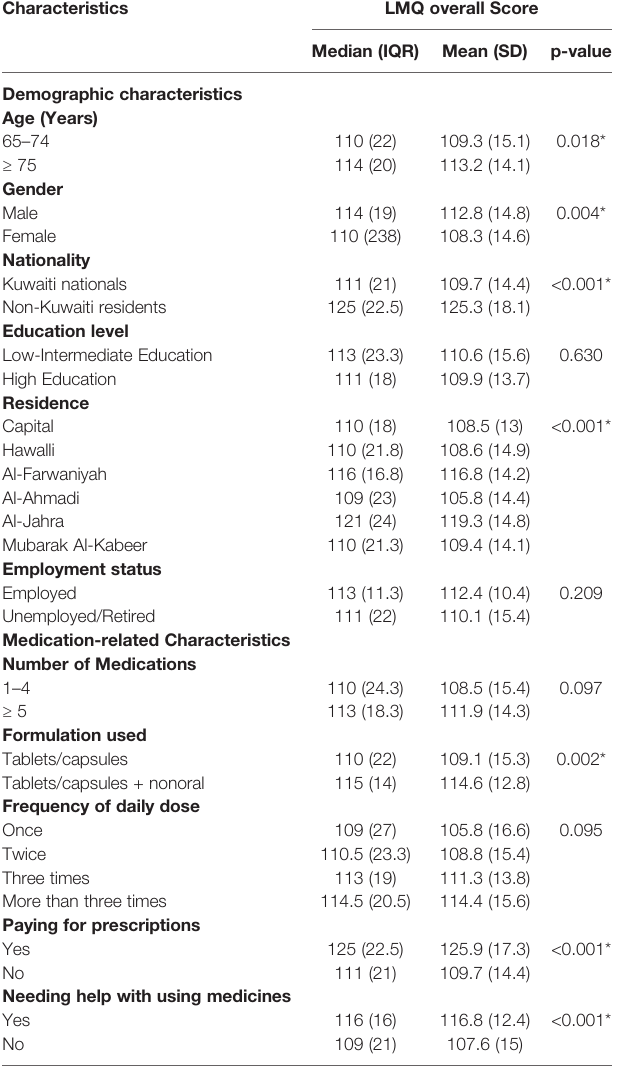
TABLE 5 | Effect of demographic and medication-related characteristics of respondents on Living with Medicines Questionnaire version-3 (LMQ-3) overall Scores